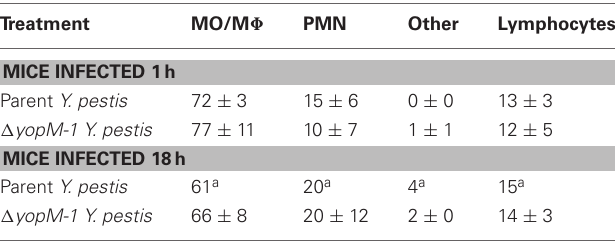
Table 5 | Distribution of morphological types among the CD11b + cells used for transcriptional analysis.